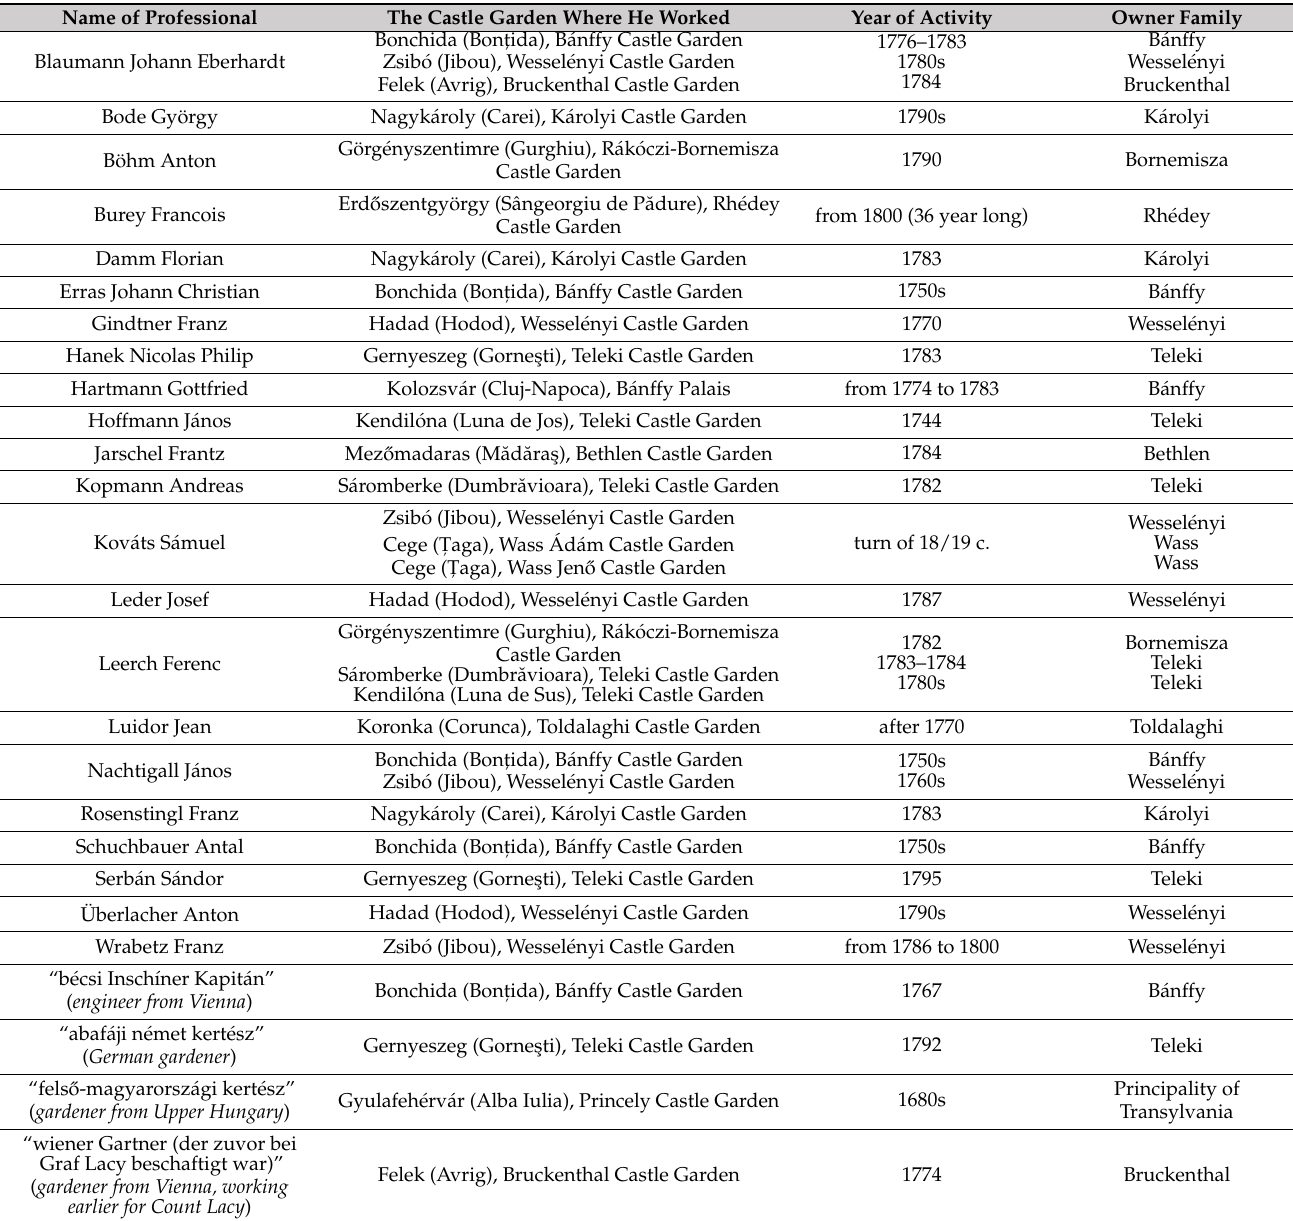
Table 2. List of professionals and estate owners contributed to the design of the significant Baroque gardens in Transylvania. Source: prepared by Albert Fekete based on research of archives and the literature